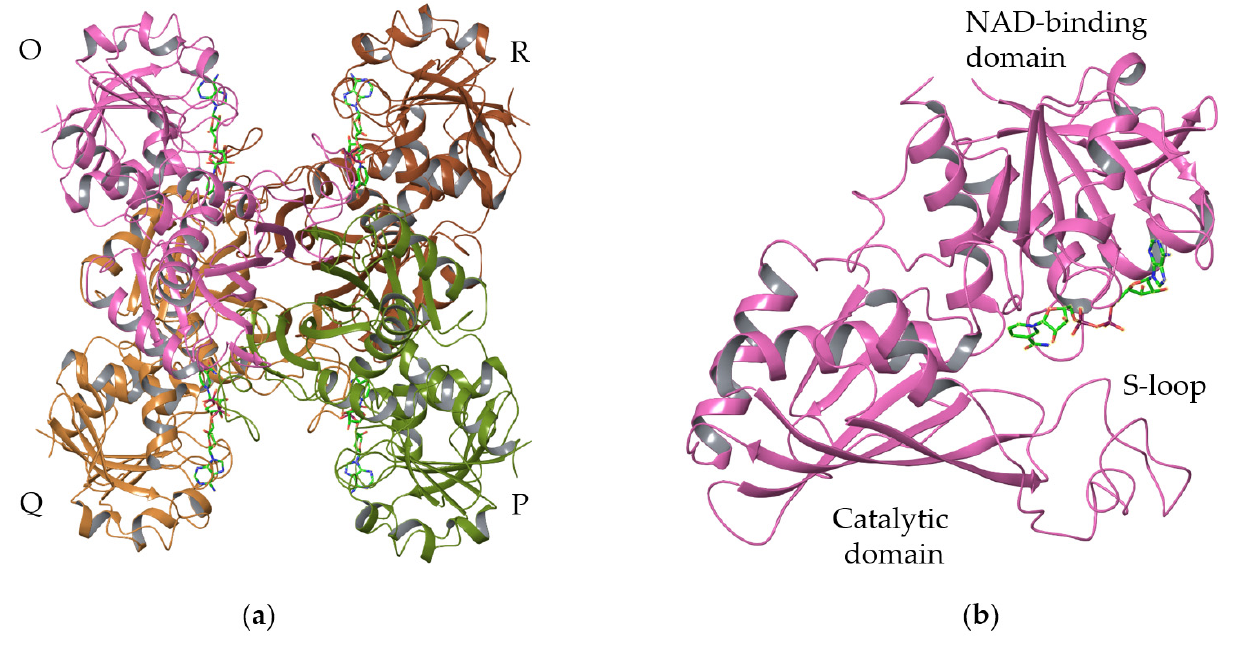
Figure 1. GAPDH oligomeric ( a ) and domain structure ( b ).